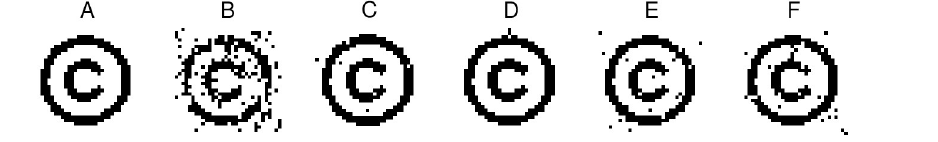
Fig 4. DWT scheme used to extract the watermark images.